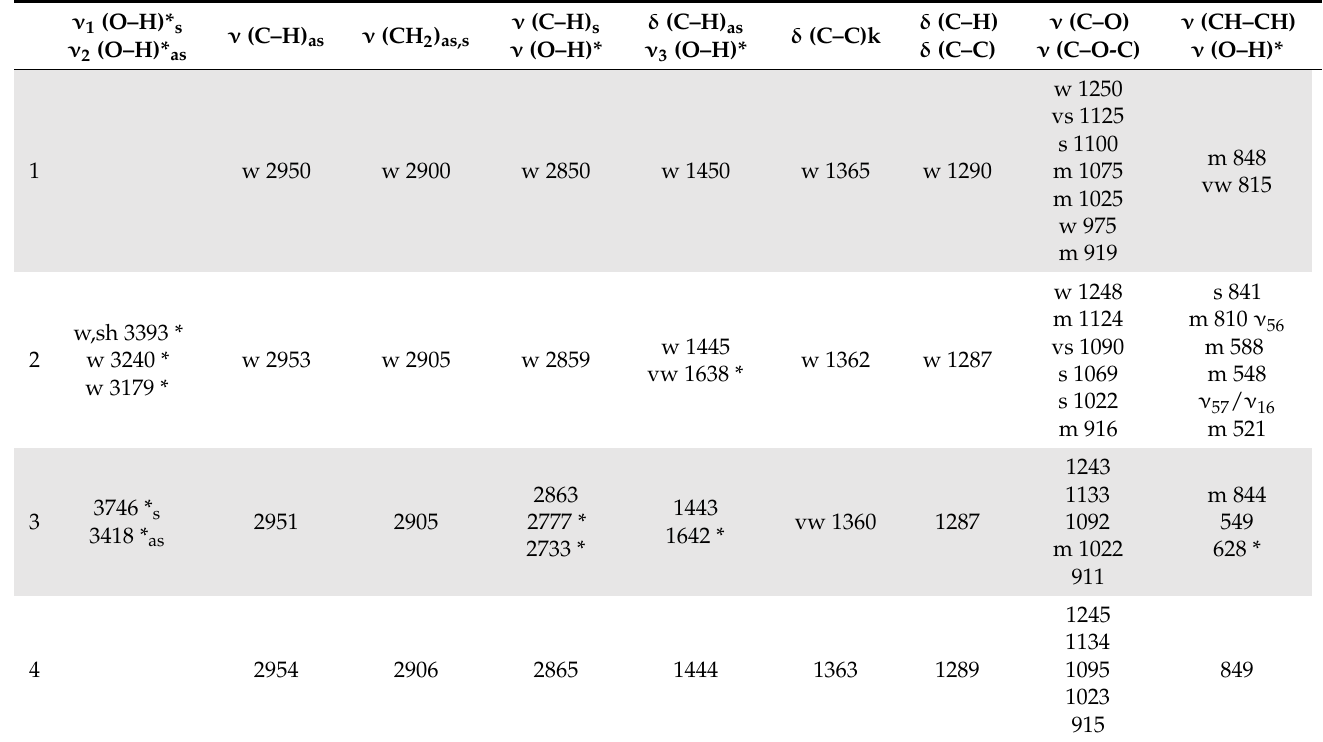
Table 4. The FTIR analysis [cm –1 ] of 12-crown-4 (1) [50], [Cu(12-crown-4) 2 ]I 5 (2),